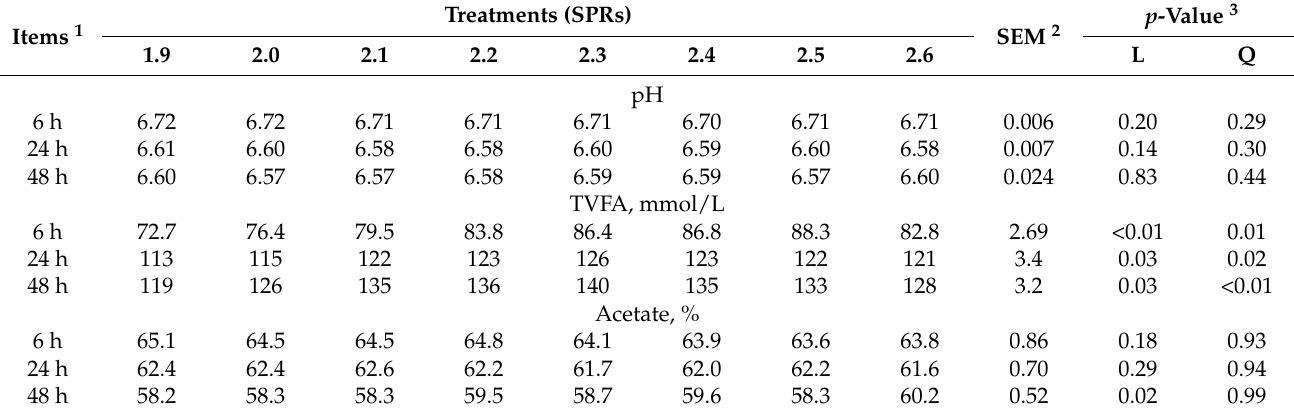
Table 5. Effects of dietary rumen-degradable starch to rumen-degradable protein ratio (SPR) on in vitro rumen fermentation parameters after 6, 24, and 48 h of